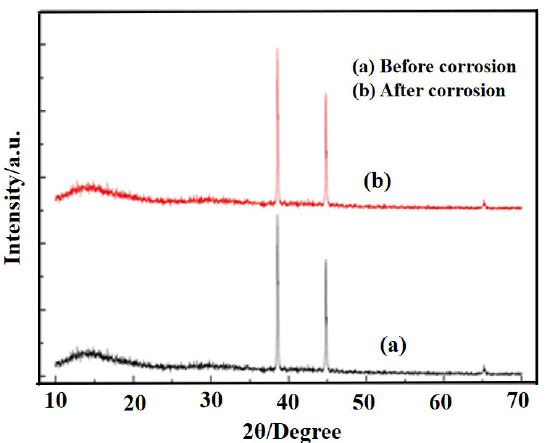
Figure 6. XRD analysis results of TiB 2 coatings before and after erosion in liquid aluminum for around 120 min. ( a ) Before corrosion. ( b ) After corrosion.